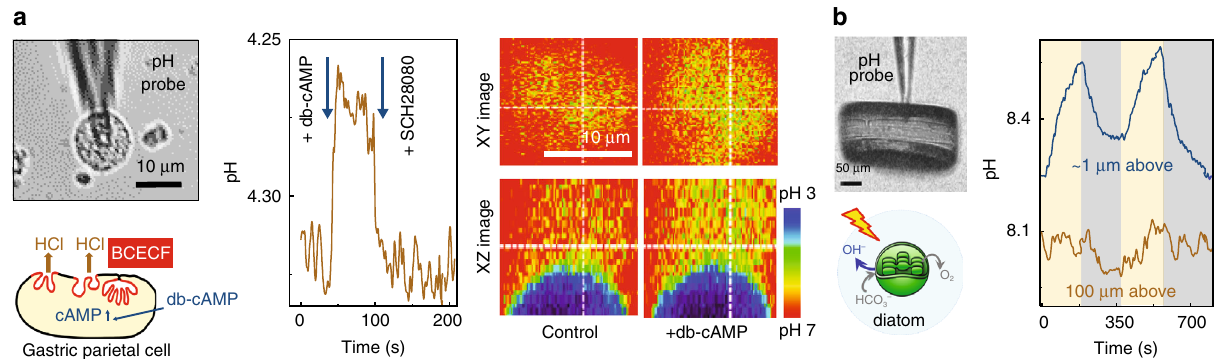
Fig. 2 SICM feedback-controlled real-time pHe detection of living cells. a Bright fi led microscopy image showing a pH-sensitive nanoprobe over a buffered single gastric parietal cell (left top). The cartoon at the bottom illustrates the construction of extracellular pH measurements (left bottom). Feedback- control allows for positioning of the pH nanoprobe to accurately detect 100 µ M db-cAMP (cAMP analogue) triggered via rapid HCl secretion from a single gastric parietal cell. The secretion can be inhibited with selective H + , K + - ATPase inhibitor SCH28080 (middle). The db-cAMP-induced HCl secretion from the gastric parietal cells was con fi rmed with pH-sensitive BCECF fl uorescent dye by confocal microscopy (right). Changes in fl uorescent intensity of pH- sensitive dye can be mapped out either by x – y or by x – z scanning. The dotted crossline marks the Z position in the XZ image and the Y position in the XY image, respectively. b pHe detection from a single low-buffered Coscinodiscus wailesii cell. Changing light conditions from illumination (yellow stripes represent light illumination) to darkness (grey stripes represent darkness), and vice versa revealed rapid pH changes ~1 µ m above the cell surface. Change in pH is almost undetectable when the probe is 100 µ m away from the cell